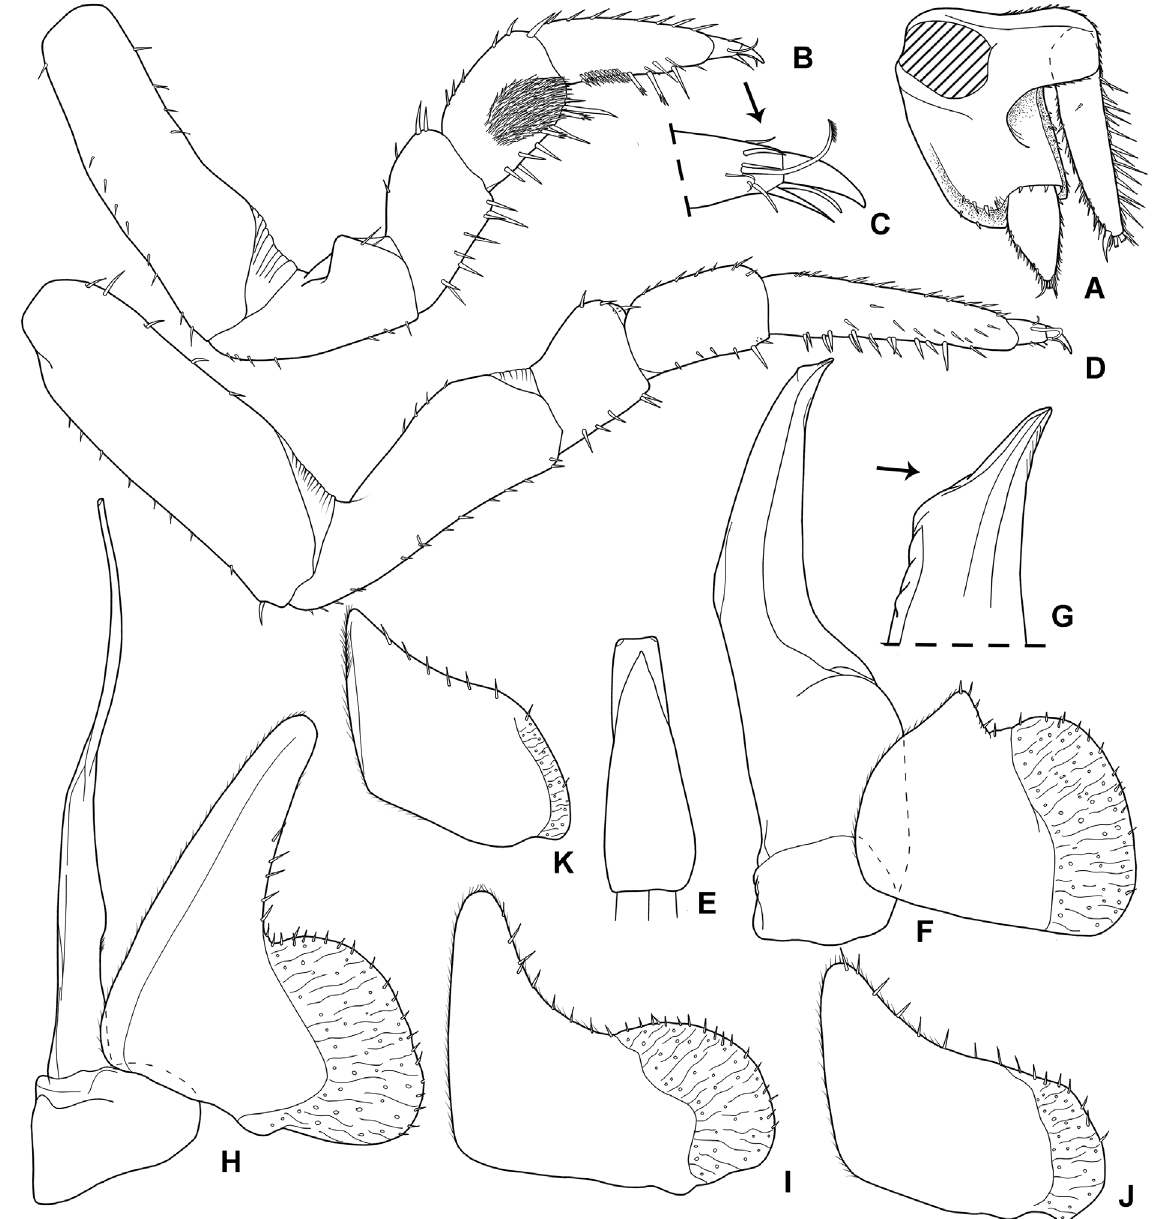
Fig. 6. Brasiloniscus littoralis gen. et sp. nov., paratype, ♂ (MZUSP 36182). A . Uropod. B . Pereopod 1. C . Pereopod 1 dactylus. D . Pereopod 7. E . Genitalia. F . Pleopod 1. G . Pleopod 1 endopod. H . Pleopod 2. I . Pleopod 3 exopod. J . Pleopod 4 exopod. K . Pleopod